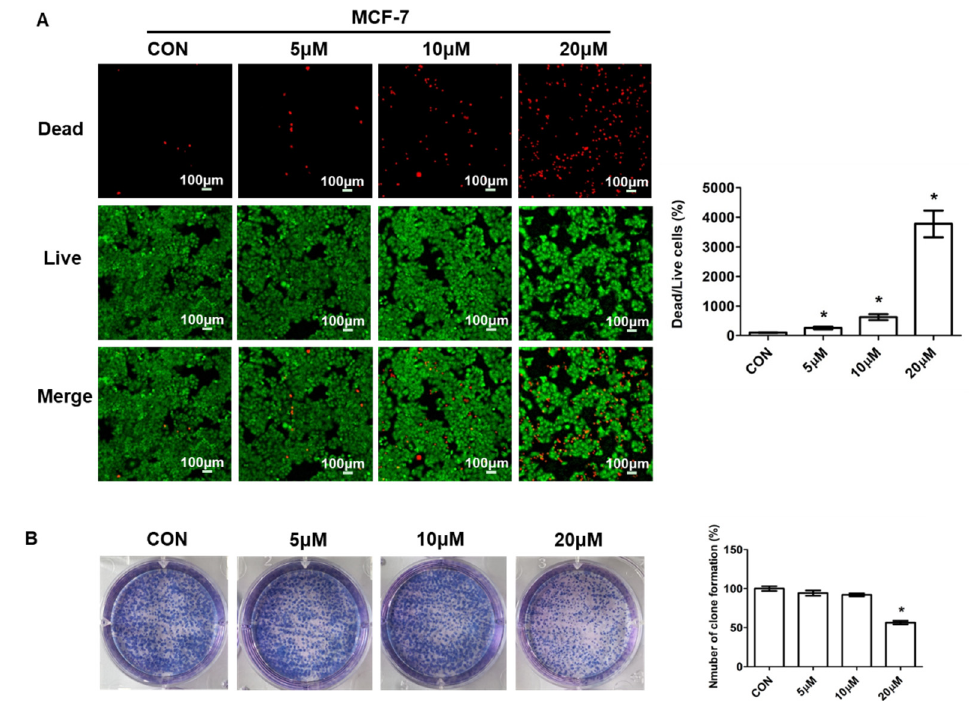
Figure 3. Compound 5d suppressed cell proliferation. ( A ) MCF-7 cells were treated with 5 μ M, 10 μ M, 20 μ M of compound 5d for 24 h, then, cells were stained with live/dead dyes. Left: fluorescence confocal images; right: ratio of dead to live cells. ( B ) MCF-7 cells were treated with 5 μ M, 10 μ M, 20 μ M of compound 5d for 48 h, then, cells were cultured continuously until single cell clone appeared, followed by staining with Giemsa dye. Left: photographs of cells; right: statistical graph. Data were presented as means ± SEM, * p < 0.05.